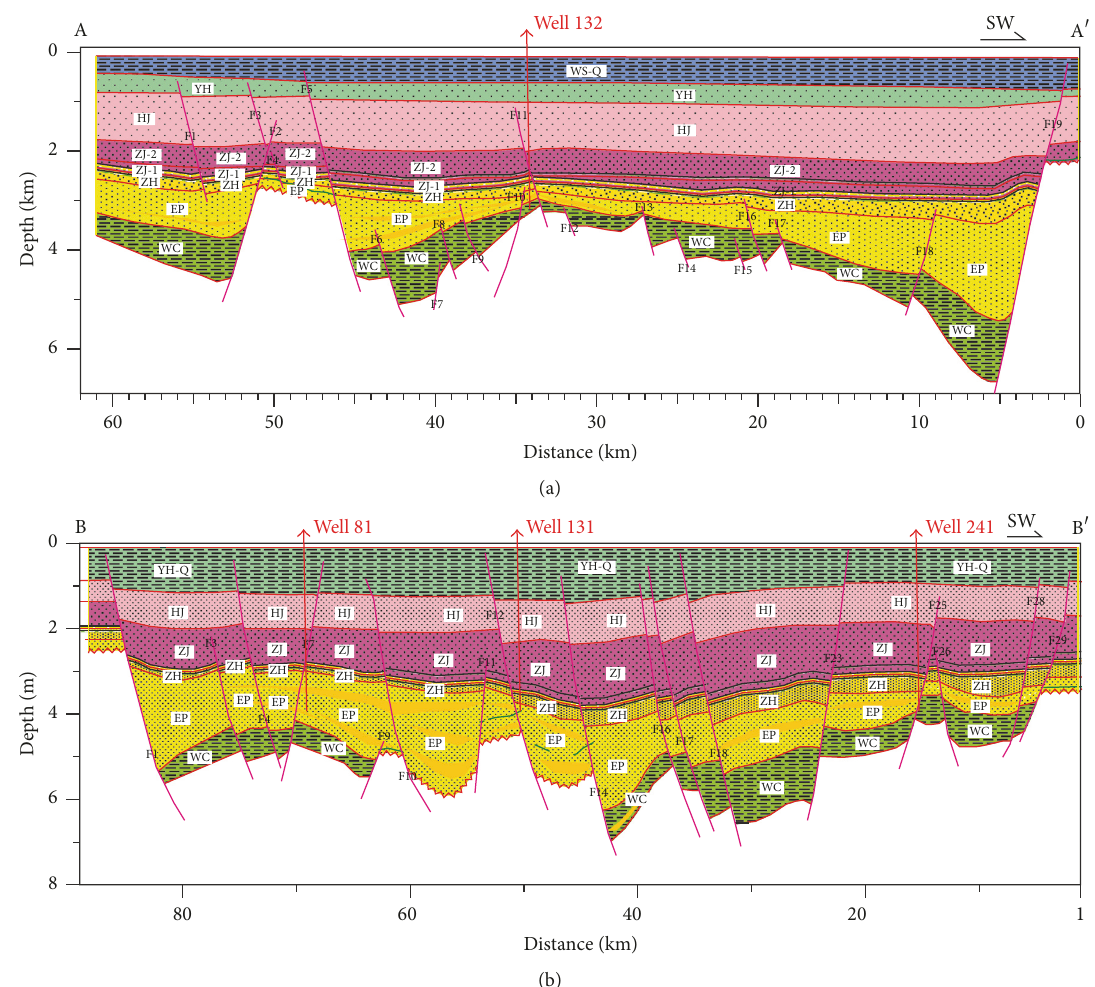
Figure 12: Two conceptual models with heterogeneous lithology in the Huizhou Sag (the locations of the profiles are shown in Figure 1). Formation names: WC = the Eocene Wenchang Formation; EP = the Eocene Enping Formation; ZH = the Oligocene Zhuhai Formation; ZJ = the Miocene Zhujiang Formation; HJ = the Miocene Hanjiang Formation; YH = the Miocene Yuehai Formation; WS-Q = the Pliocene Wanshan Formation to Quaternary; YH-Q = the Miocene Yuehai Formation to